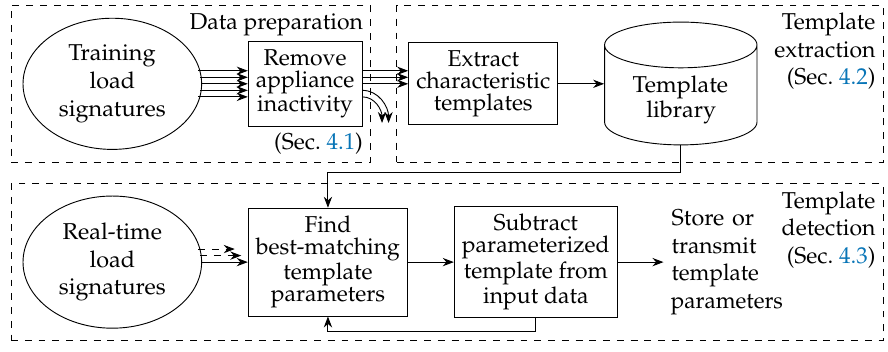
Figure 4. Processing flow for the extraction and detection of templates in microscopic load